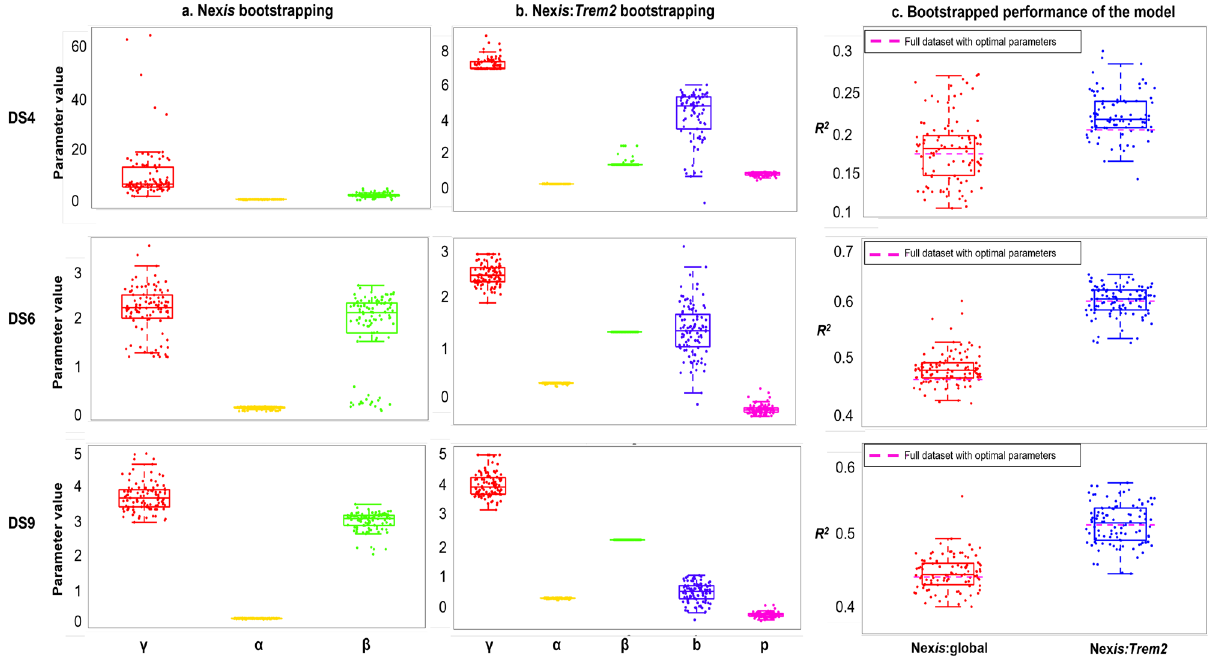
Figure 3. Mean and 95% confidence intervals for the global and microglial parameters as well as model fit for datasets DS4, DS6, and DS9. Panels ( a ) and ( b ): 100-iteration 80% resampled bootstrapped values of the Nex is :global and Nex is : Trem2 model parameters. Panel ( c ): Comparison between model fits of the 80% resampled bootstrapped dataset with the full dataset (magenta dotted line). Global parameters: γ (seed rescale), α (intra-regional tau accumulation rate), and β (inter-regional tau spread rate). Microglial parameters: p (microglia-mediated intra-regional tau accumulation rate) and b (microglia-mediated inter-regional tau spread rate). Model fit is depicted by R 2